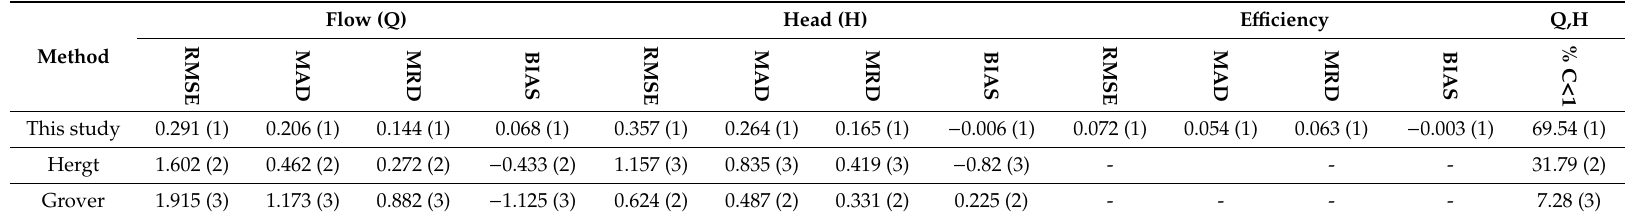
(x) indicates the classified order of the method considering the rest of